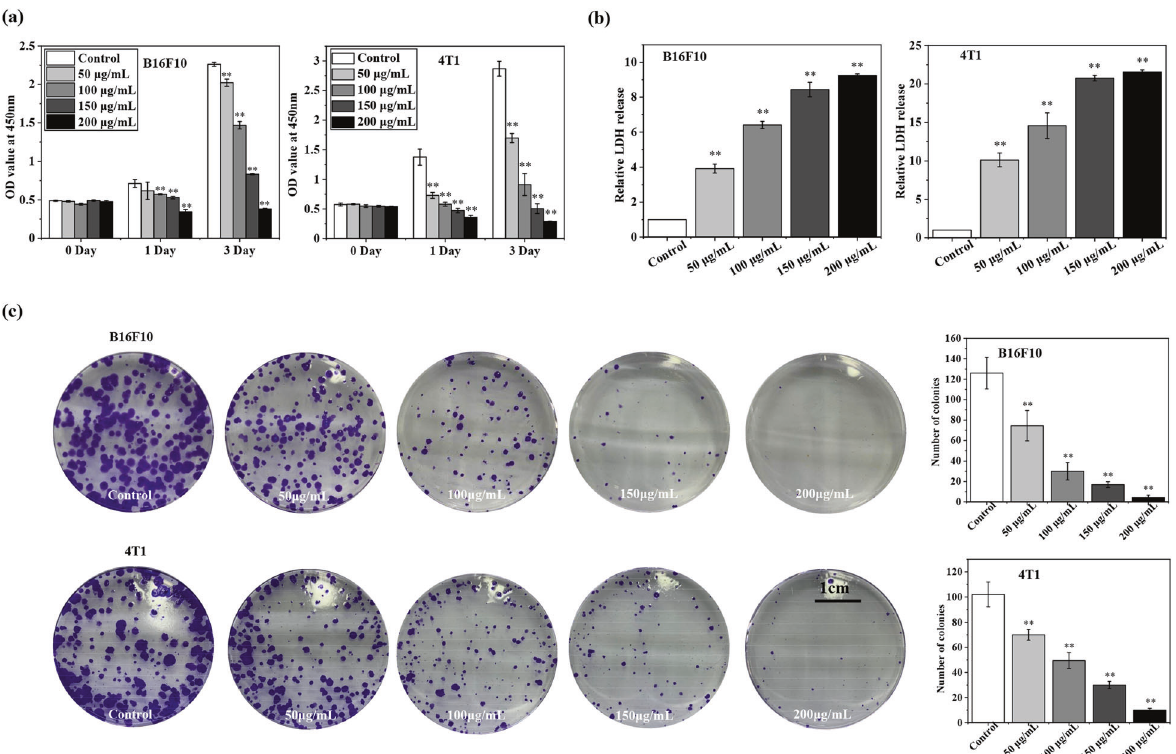
Fig. 2 JM2 inhibited proliferation of tumor cells. a Cell proliferation evaluation of B16F10 and 4T1 cells cultured with JM2 solutions with different concentrations. b Lactate dehydrogenase analysis of B16F10 and 4T1 cells cultured with JM2 solutions with different concentrations. c Colony formation of B16F10 and 4T1 cells cultured with JM2 solutions with different concentrations. * p < 0.05 and ** p < 0.01 when the data was compared with the Control